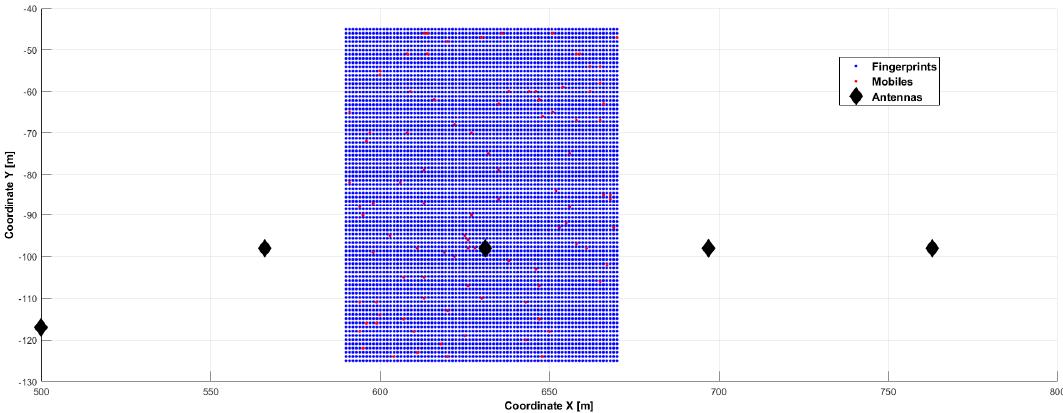
Figure 14. 2D view of Terminal 4 at Adolfo-Suarez Madrid-Barajas International Airport simulation area: A section of 80 × 80 m containing 6400 fingerprints, 99 mobiles to locate and 5 APs. • Case 3: Grid size of 200 × 120